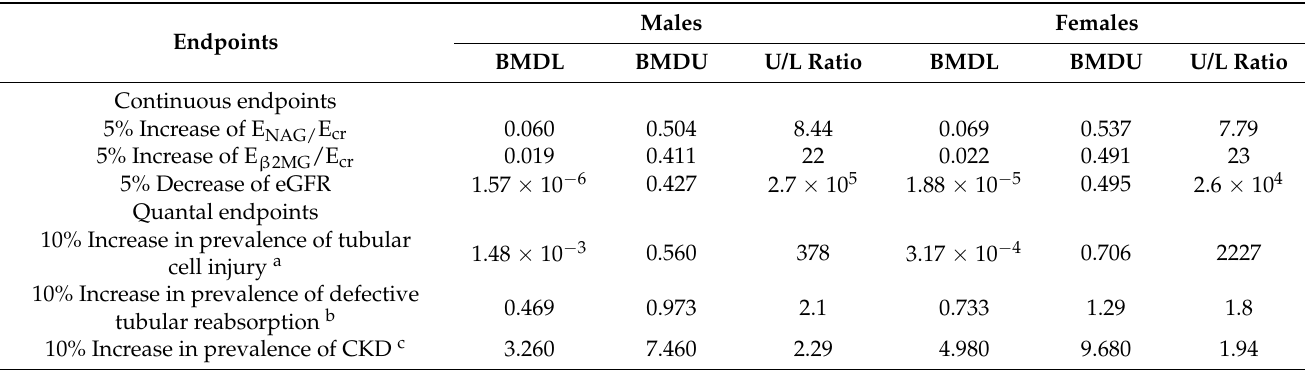
Table 3. BMDL and BMDU values of cadmium accumulation associated with adverse effects on kidneys according to E cr -normalized